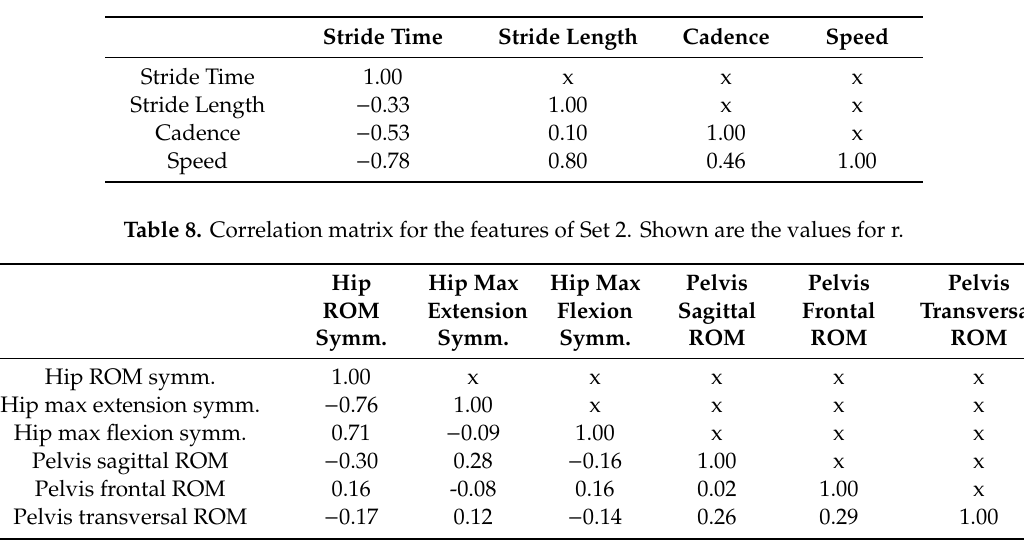
Table 7. Correlation matrix for the features of Set 1. Shown are the values for r.